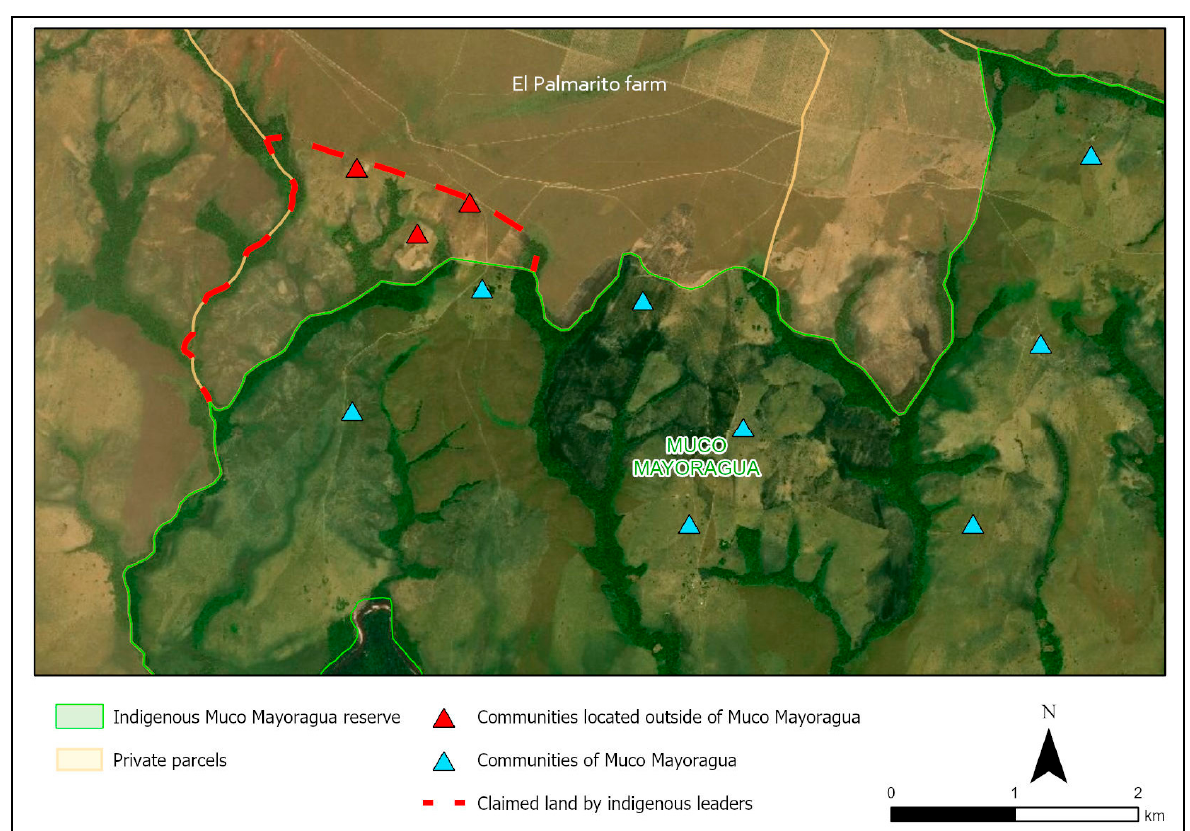
Figure 9. The area that is claimed by the Indigenous Muco Mayoragua reserve (red dotted line). They claim 245 ha of land that is private land (El Palmarito private farm), according to the government. There are three committees of the reserve that are located in these 245 ha. Cumaribo, 2020. Source: Land in Peace Project, Kadaster.